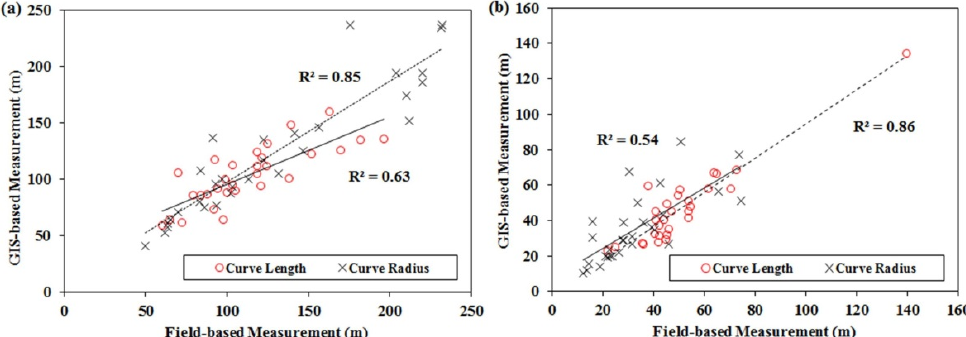
Figure 5. The comparison of rural road ( a ) and forest road ( b ) curve data obtained from field measurement and GIS-assisted satellite images.